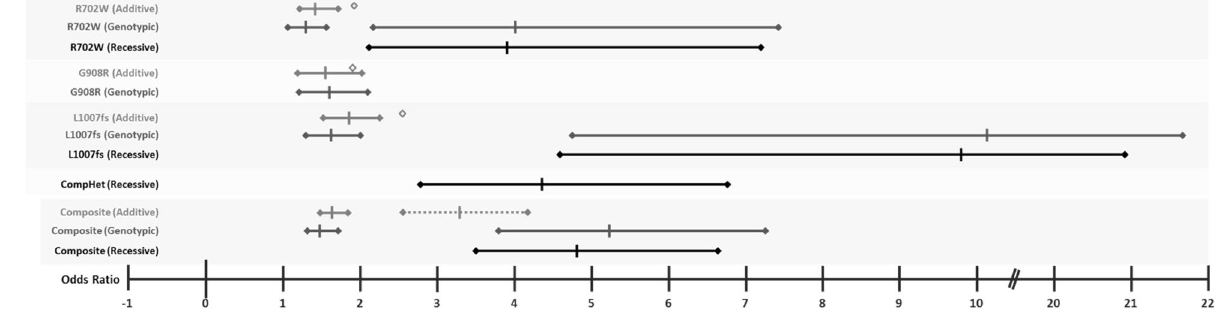
Figure 3. Graphical representation of Odds Ratio (OR) point estimates and 95% confidence intervals (CI) for the three main CD risk alleles (p.R702W, p.G908R, p.L1007fs) under additive, genotypic, and recessive genetic models (corresponding to values in Table 3). The dotted line in the Composite panel depicts the calculated CI with corresponding calculated OR for 2 alleles under an additive genetic model; of note the point estimate (2xOR) is outside of the 95% CI for the Composite genotypic homozygous and recessive models. Diamonds correspond to estimated OR values for these same variants in the IBD Exomes Browser 49 ; no confidence intervals are